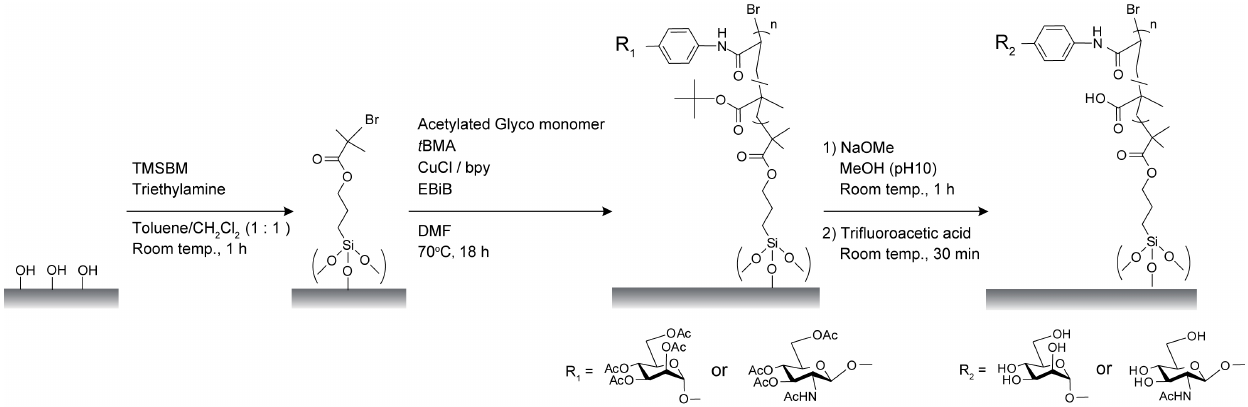
Figure 1. Preparation of poly(glyco-MA)-immobilized materials using surface-initiated atom transfer radical polymerization (SI-ATRP).